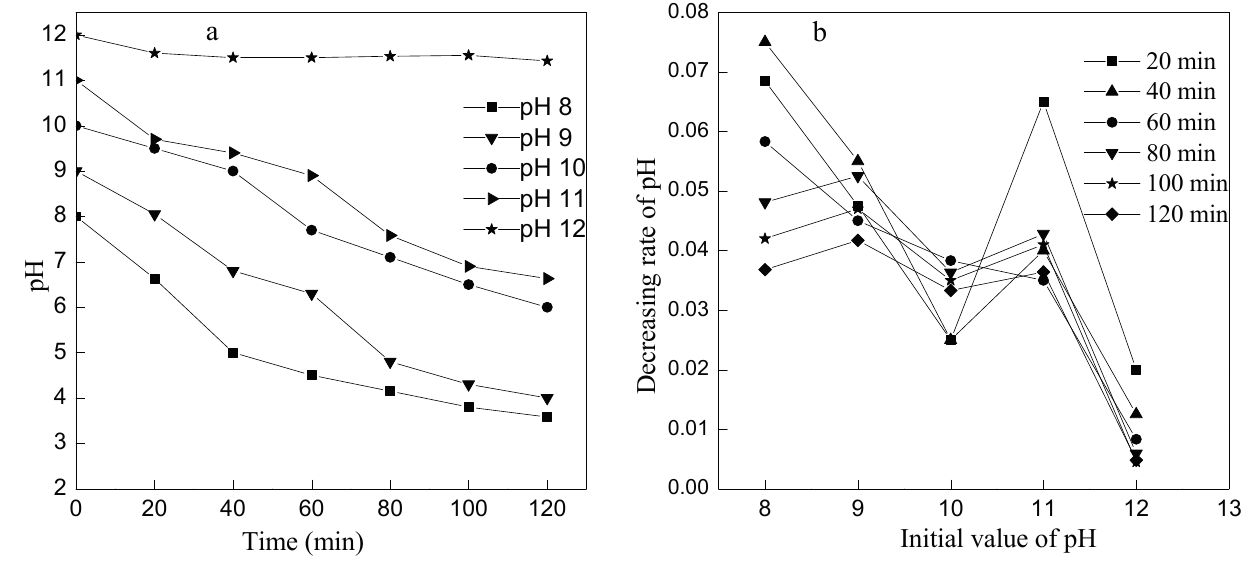
Figure 5. Effect of initial pH on oxidation of ammonia. ( a ) The effect of initial pH on removal efficiency of ammonia; ( b ) The effect of initial pH on removal rate of ammonia.